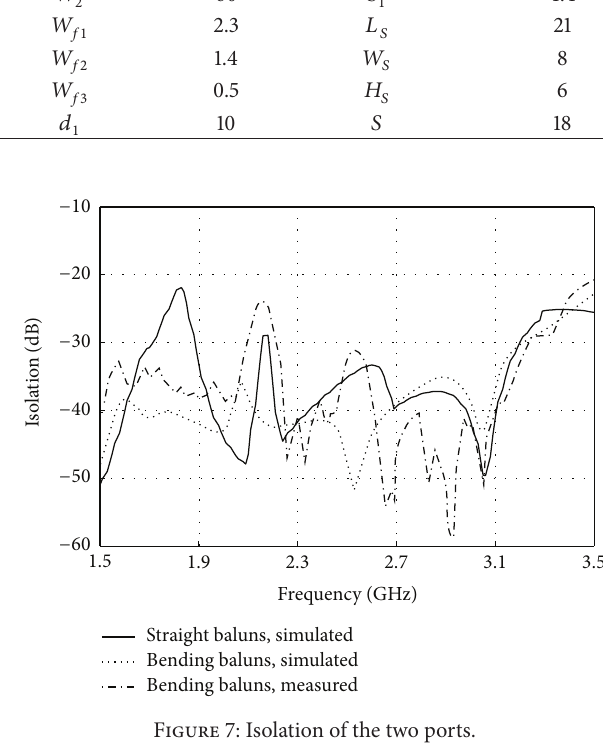
Figure 7: Isolation of the two ports.